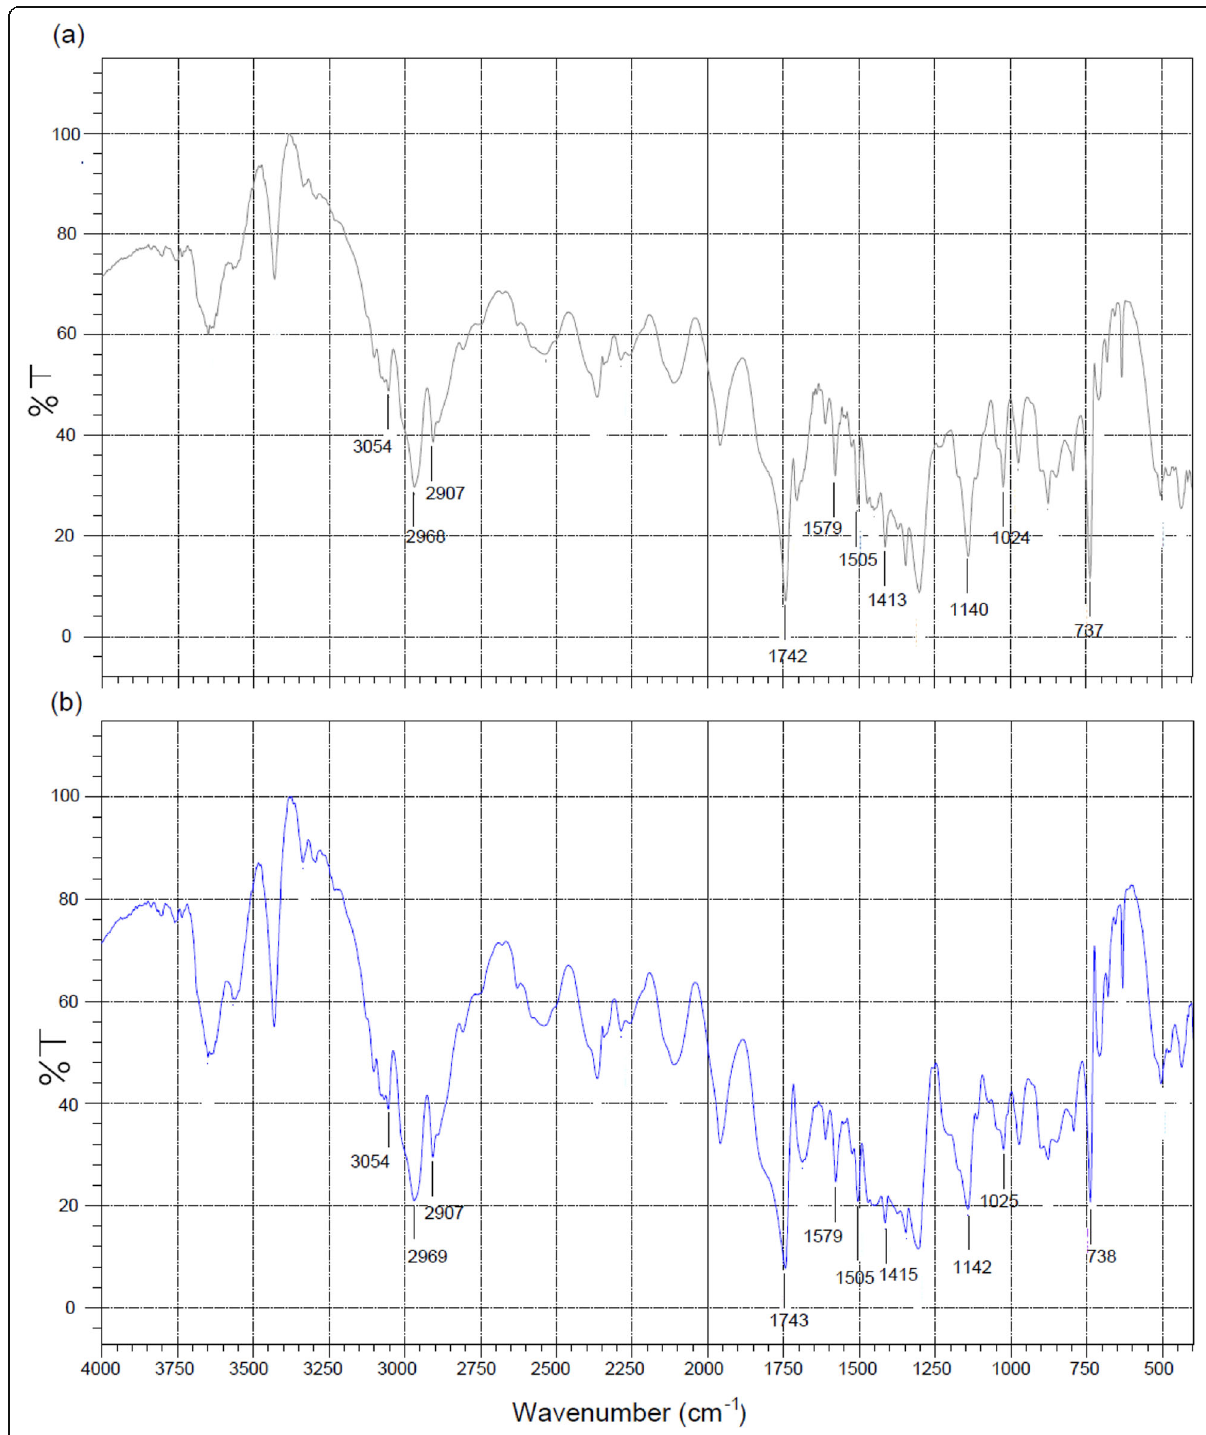
Fig. 1 FTIR spectra of PET membrane: ( a ) using PET bottle as the polymer source, ( b ) using PET resin as the polymer Effect of PEG 400 concentration on the microstructure, hydrophilicity and porosity The use of additives for the preparation of membrane by using the phase inversion technique has been known to